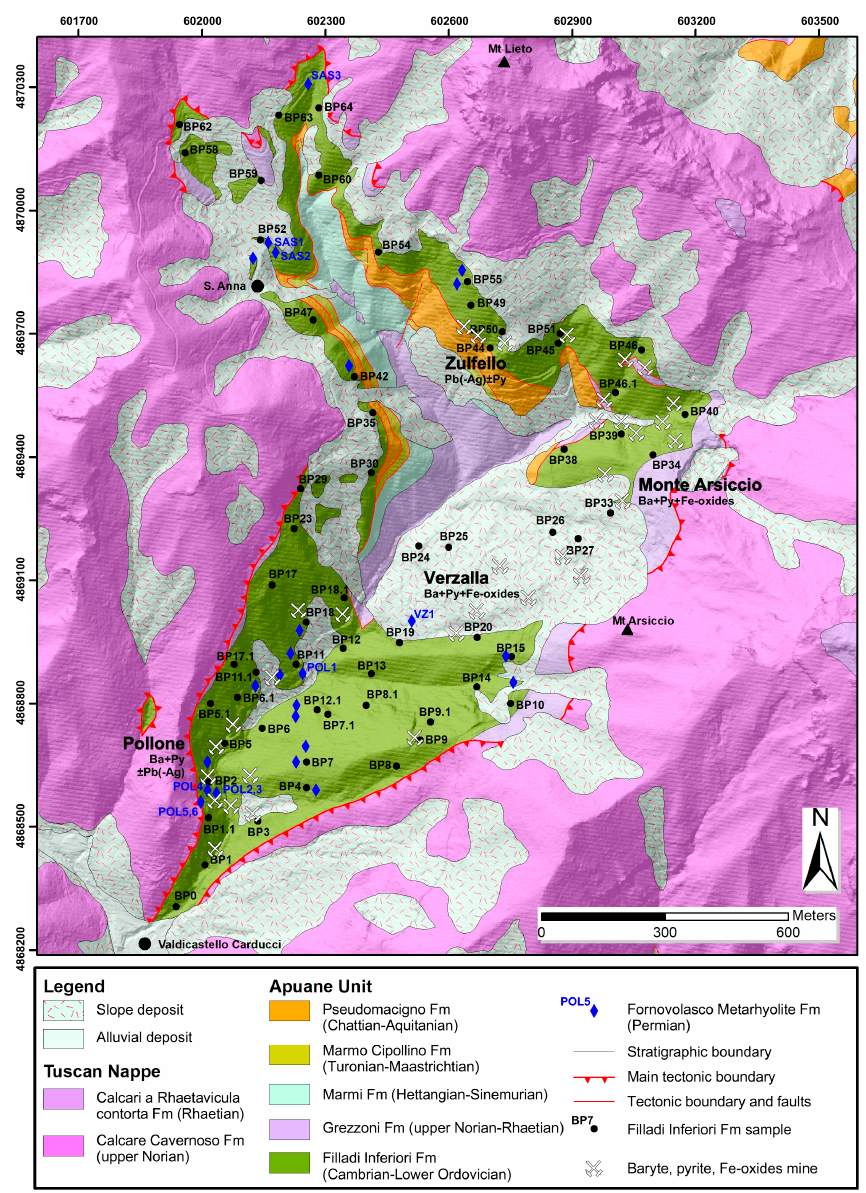
Figure 2. Geological map of the Sant’Anna tectonic window (modified after Conti et al. [22]) with locations of the main abandoned mines. The “Filladi Inferiori” and Fornovolasco Metarhyolites samples are also shown.